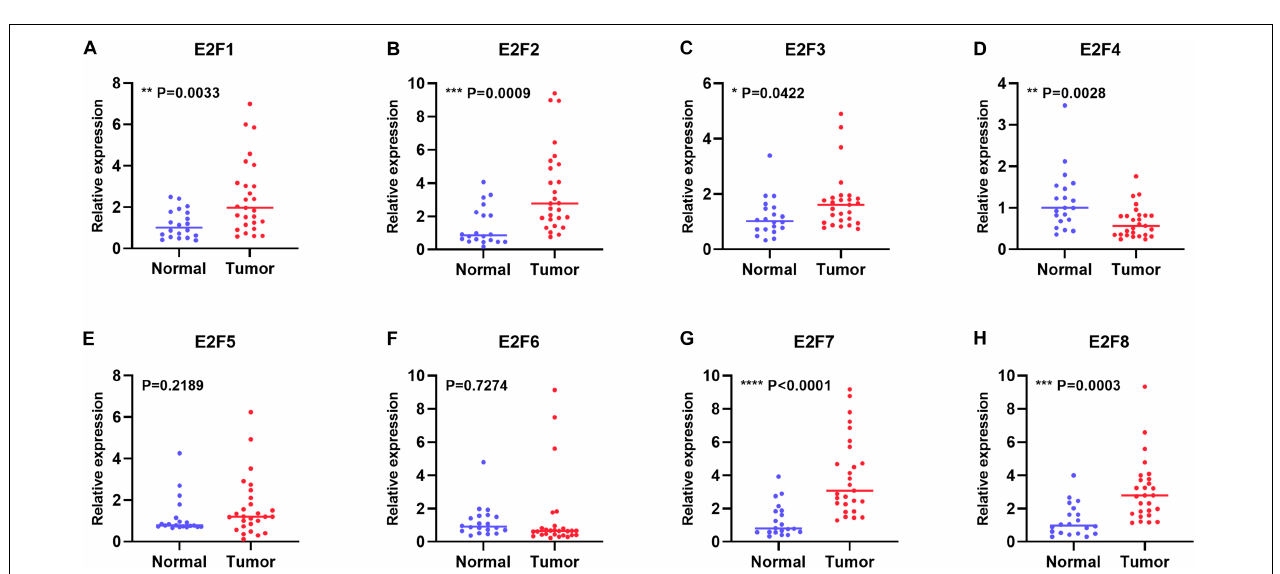
FIGURE 1 | The level of E2Fs in normal and UCEC tissues. Box plots showed the expression of E2F1 (A) , E2F2 (B) , E2F3 (C) , E2F4 (D) , E2F5 (E) , E2F6 (F) , E2F7 (G) , and E2F8 (H) in UCEC tissue and normal tissues.